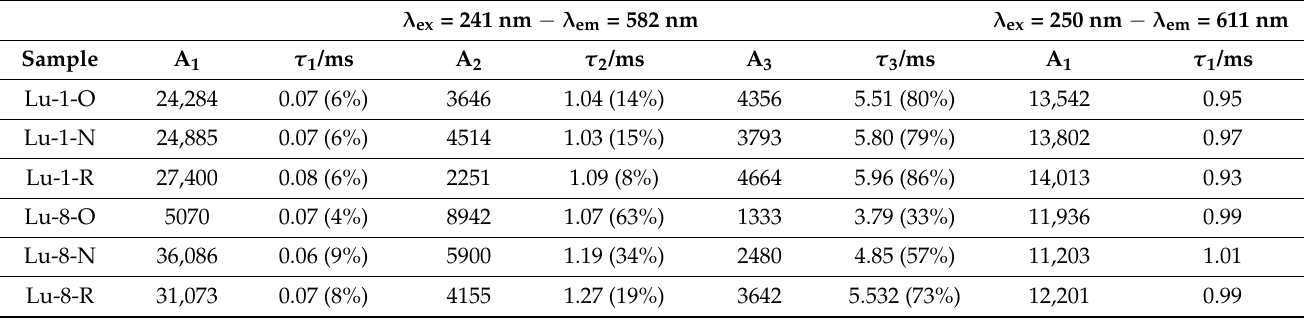
Figure 4. Normalized PL spectra Lu 2 O 3 :1%Eu and Lu 2 O 3 :8%Eu single crystals for ( a ) and ( c ) Eu(S 6 ) characteristic excitation under 241 nm ( b ) and ( d ) Eu(C 2 ) characteristic excitation under 250 nm. The inserts present PL spectra in the range of 578–590 nm. Table 1. The decay time fitted results of Lu 2 O 3 :1%Eu and Lu 2 O 3 :8%Eu single